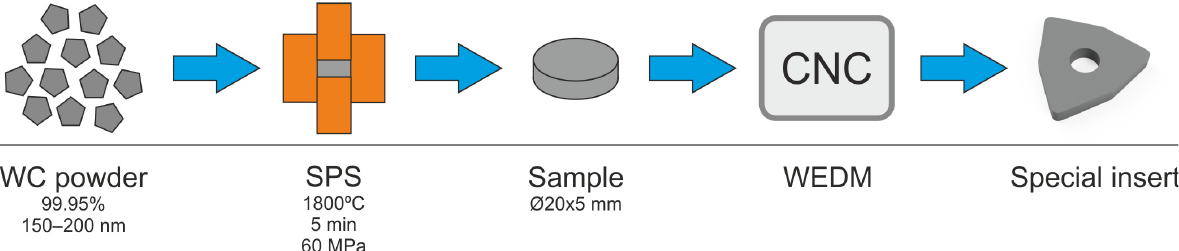
Figure 2. The tool holder with internal cooling channels used in the research. Figure 3. Schematic diagram of the special insert’s process preparation. Figure 3. Schematic diagram of the special insert’s process preparation. Figure 3. Schematic diagram of the special insert’s process